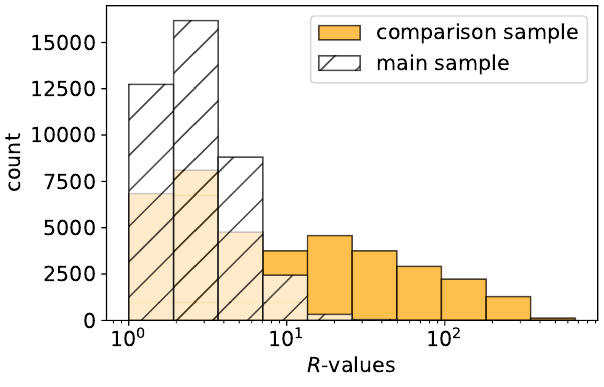
Figure 10: Distribution of R -values in the main sample (hatched) and the comparison sample (orange).